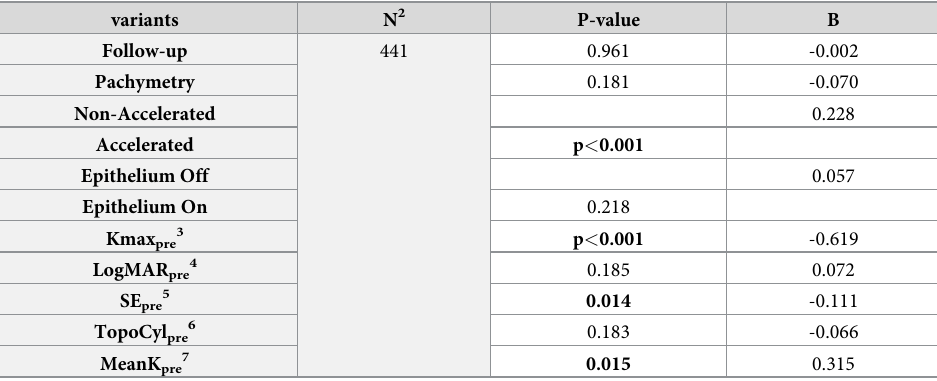
Table 4. Multivariate analysis of variables affecting Delta